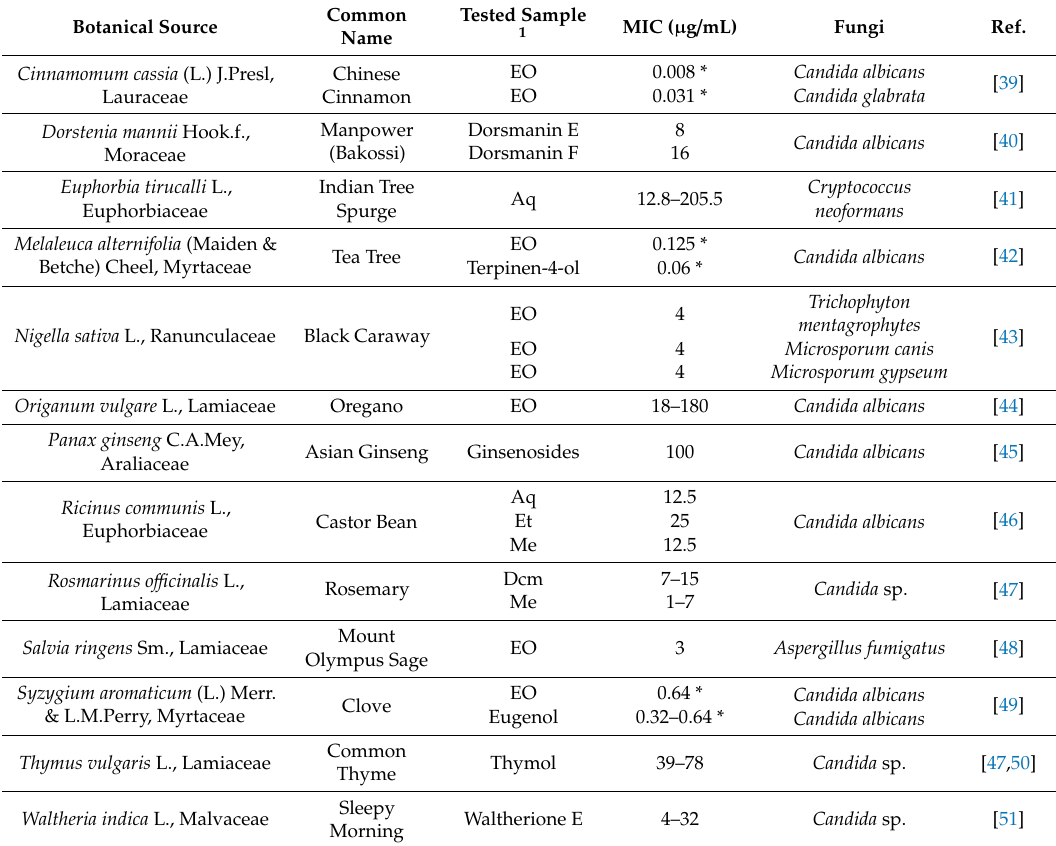
Table 1. Antifungal activity of select plant